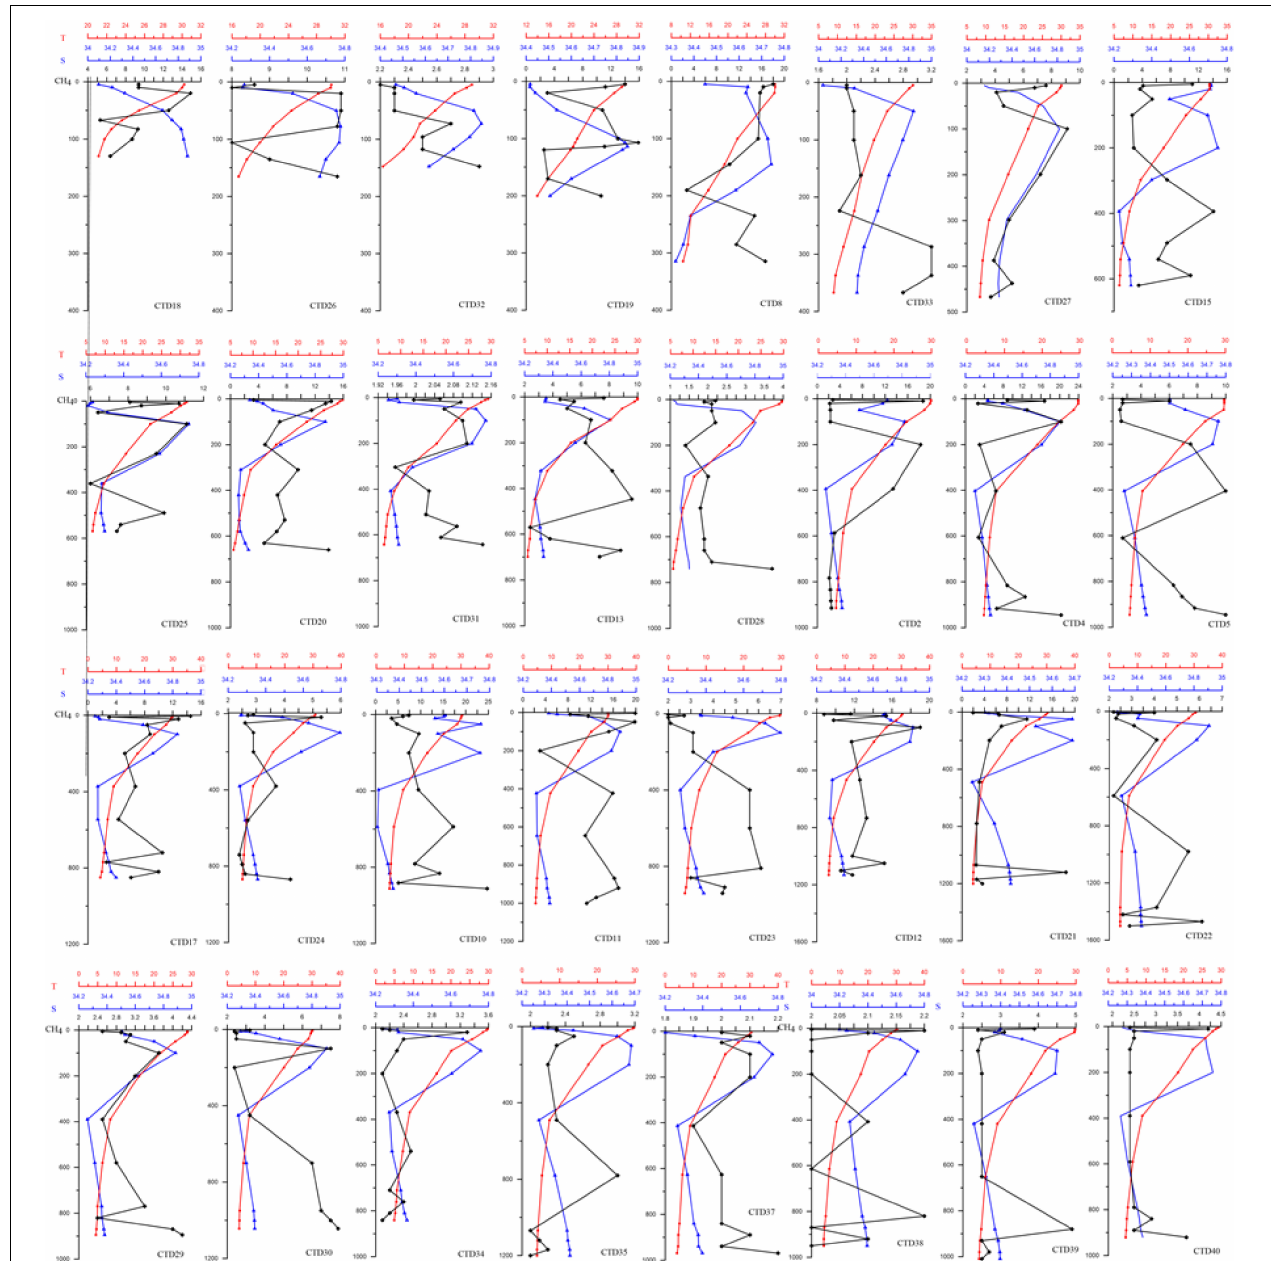
), and CH 4 (nM) at representative stations of the (cid:104)